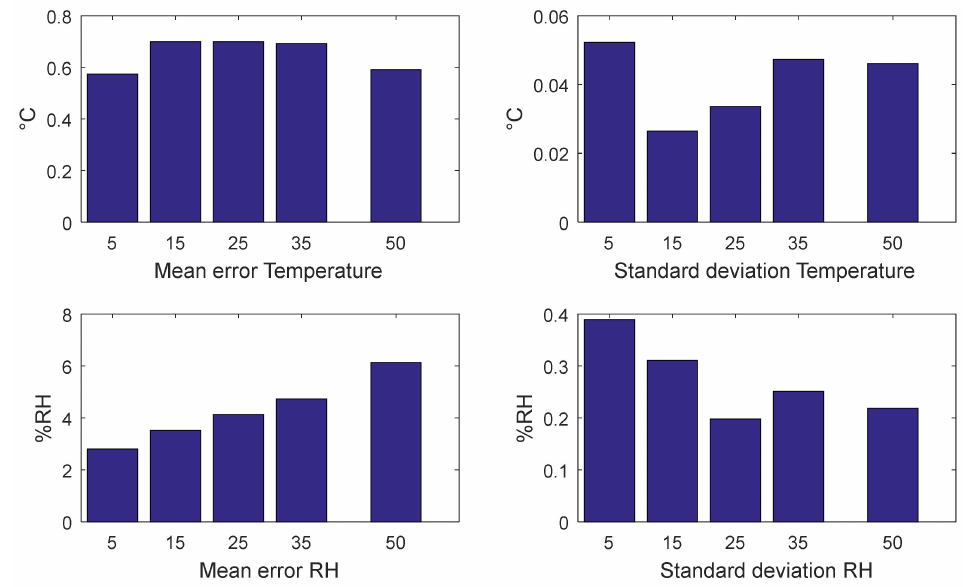
Figure 14. Mean error and standard deviation between the temperature and relative humidity measured by the node and the reference during the steady states.